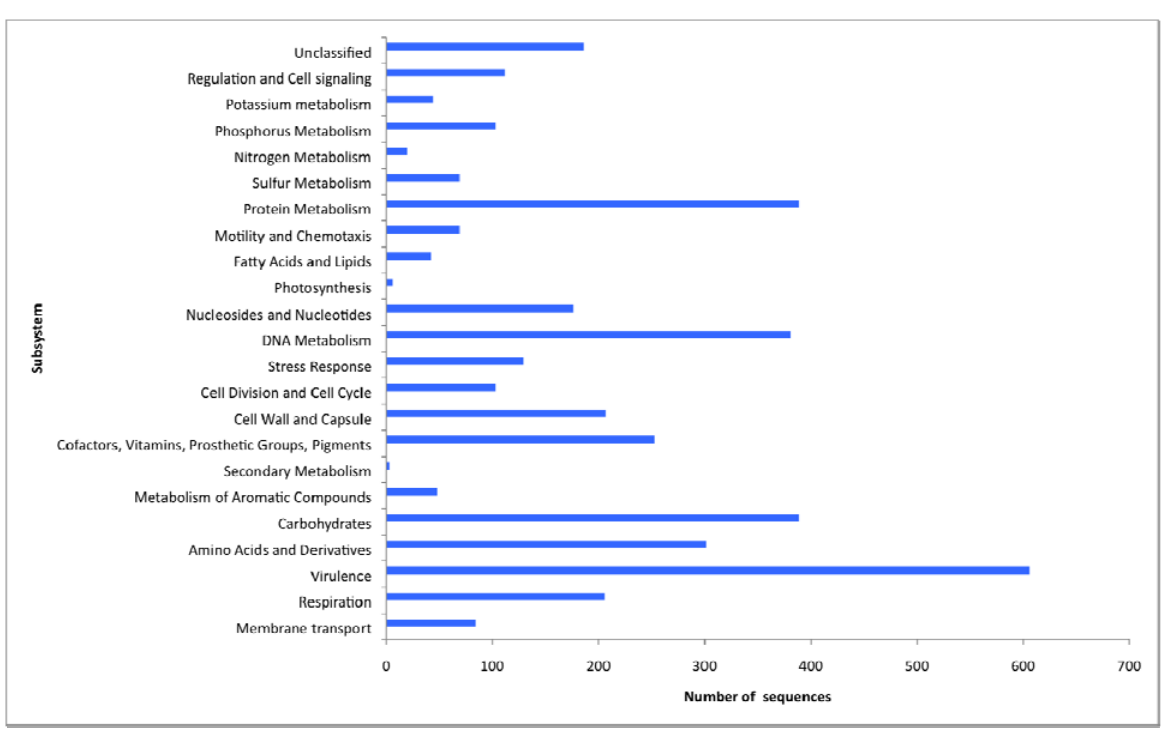
Figure 1. Functional potential of sequences from the freshwater virome. This was calculated using a BLASTX algorithm against the SEED database. An E-value of <0.001 was considered to be